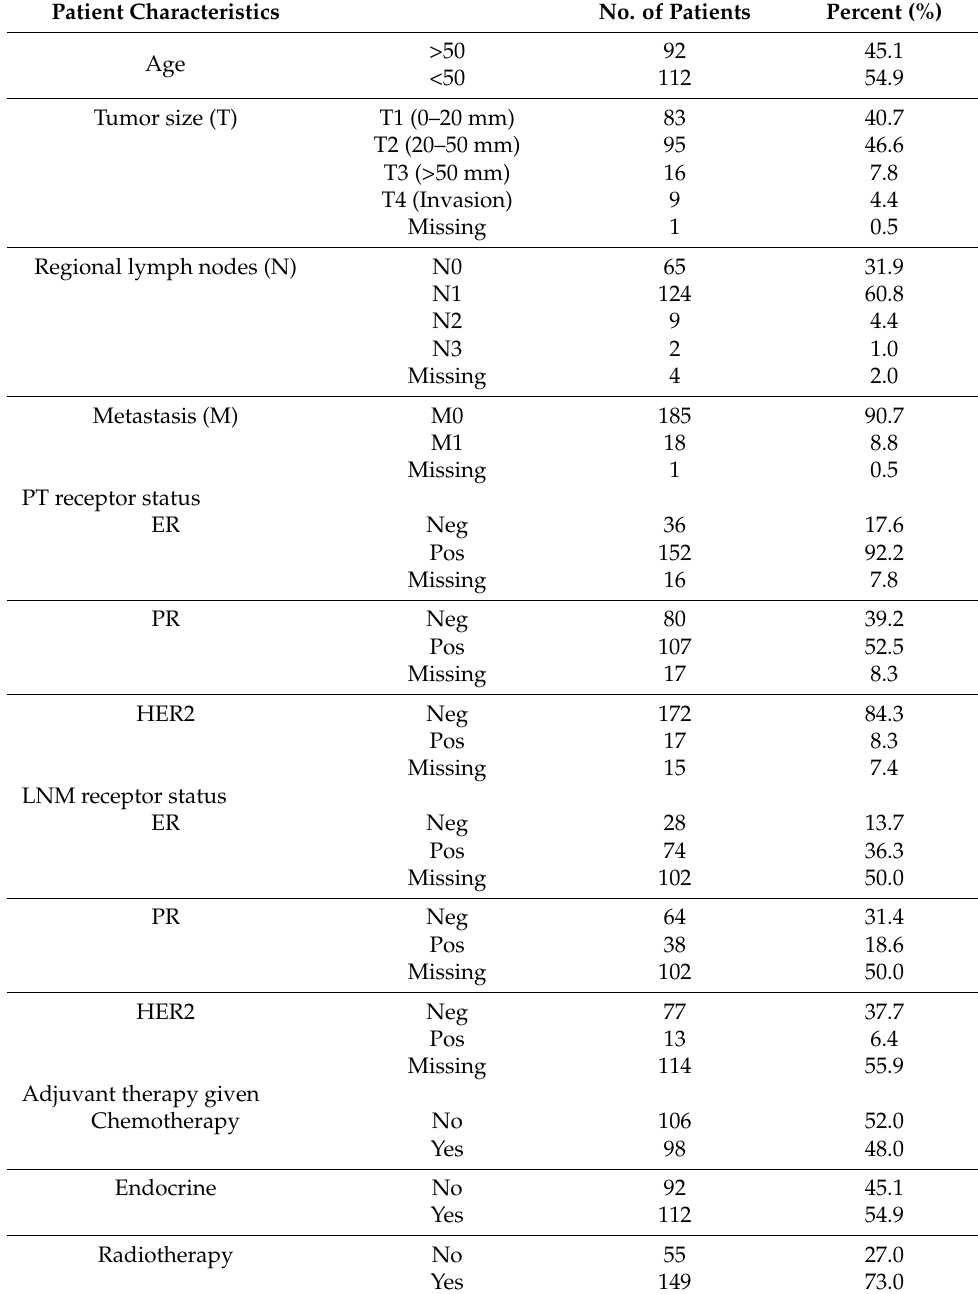
Table 1. Patient characteristics and clinicopathological features of patients included in the TEX study [28]. Patient